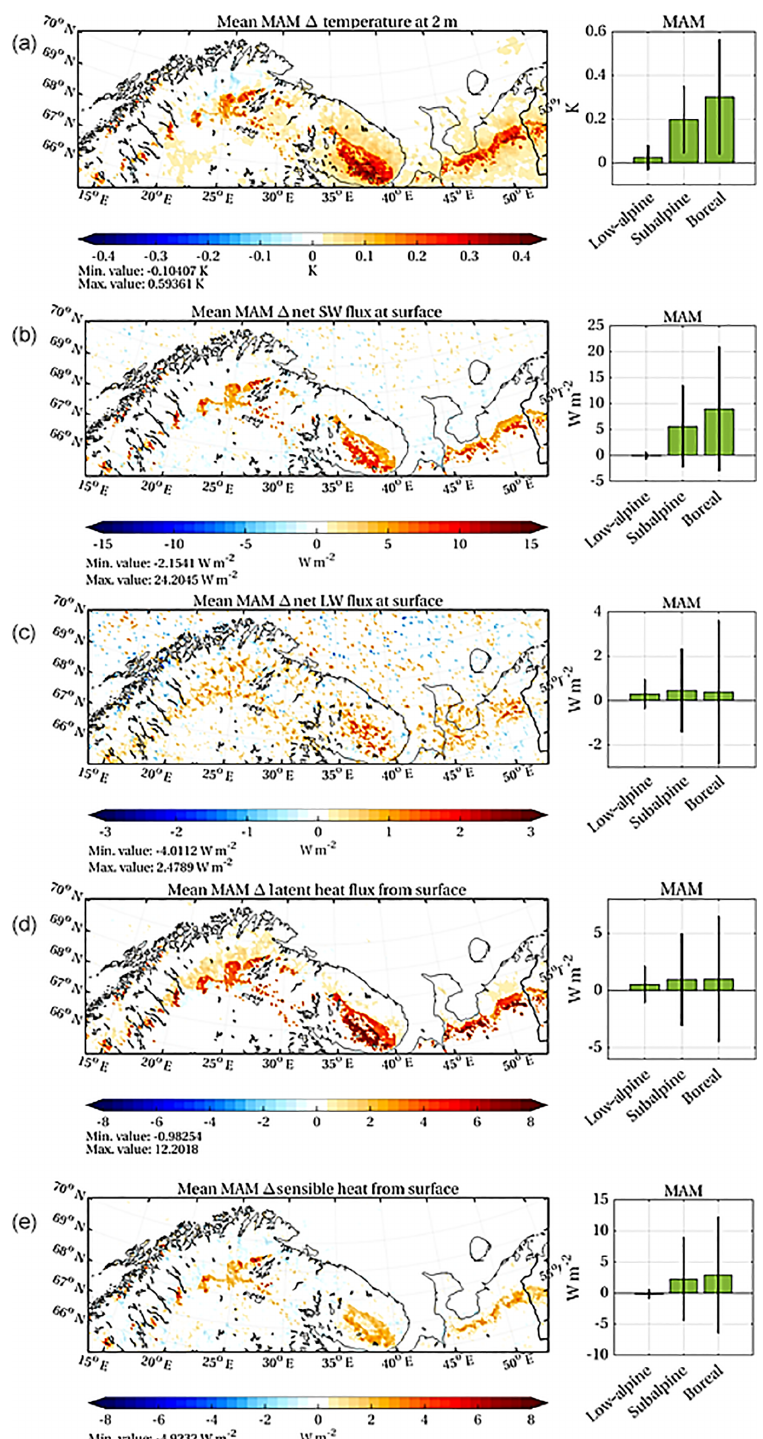
Figure 4. Effects of increased shrub cover (Veg0K–RefVeg) on the MAM season (a) 2m temperature, surface fluxes of (b) net SW and (c) LW radiation (both direction downward). Fluxes of (d) LH and (e) SH (direction upward from surface). The minimum and maximum in mean seasonal values are shown below each map to present the full spatial variation in the average seasonal response. Colours only show significant results at the 95% confidence level based on a Mann–Whitney test of equal medians. Bar plots indicate the mean response as averaged over the separate areas with vegetation changes (black lines indicate 1 σ range about the mean). Note that scales differ among